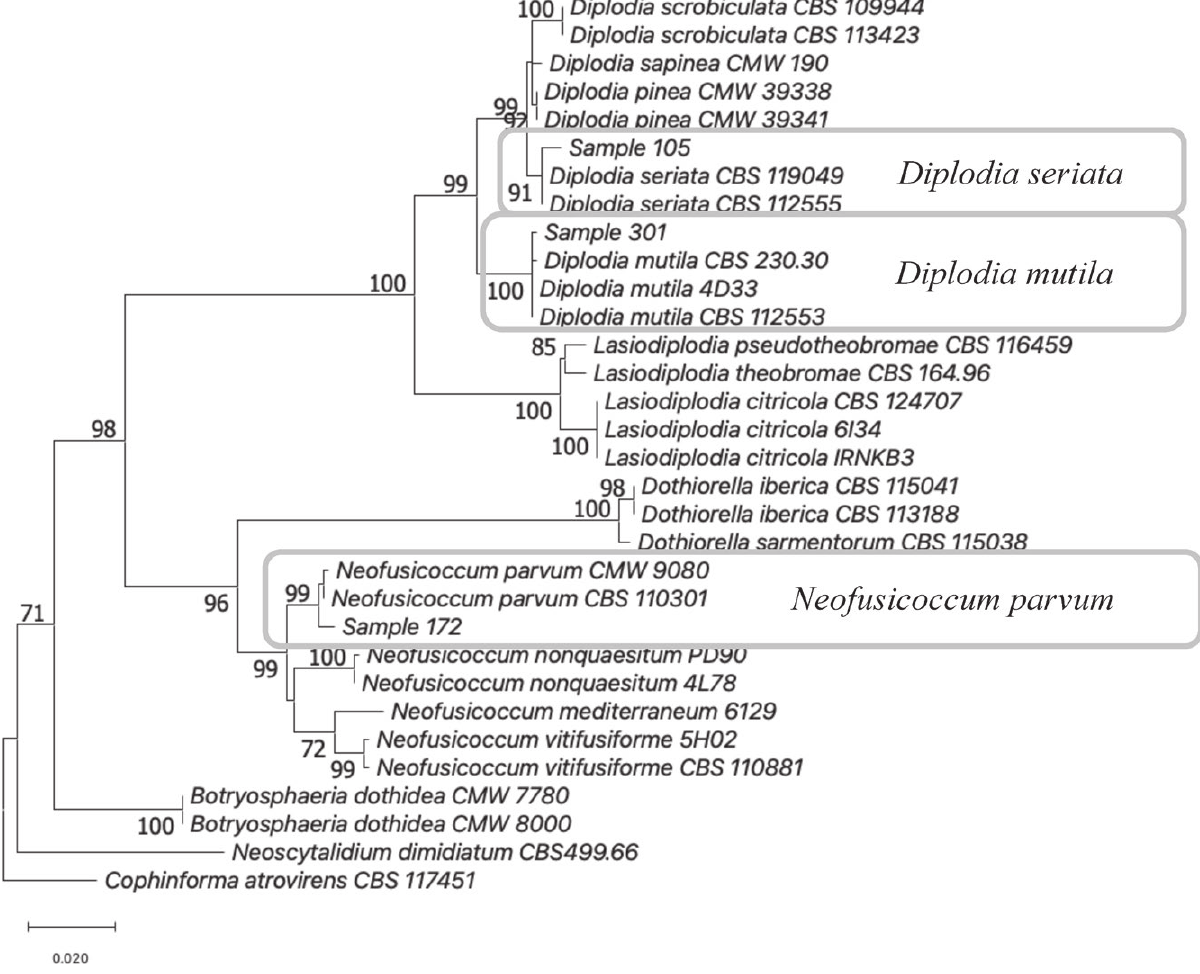
Figure 1. Phylogenetic tree reconstructed by maximum likelihood analysis from the concatenated sequences of the nuclear ribosomal internal transcribed spacer, translation elongation factor and beta-tubulin for three Botryosphaeriaceae species isolated from three walnut orchards in Chile and 29 Botryosphaeriaceae reference sequences retrieved from the GenBank database. The tree is drawn to scale, with branch lengths measured in the number of substitutions per site. Numbers on branches are bootstrap support